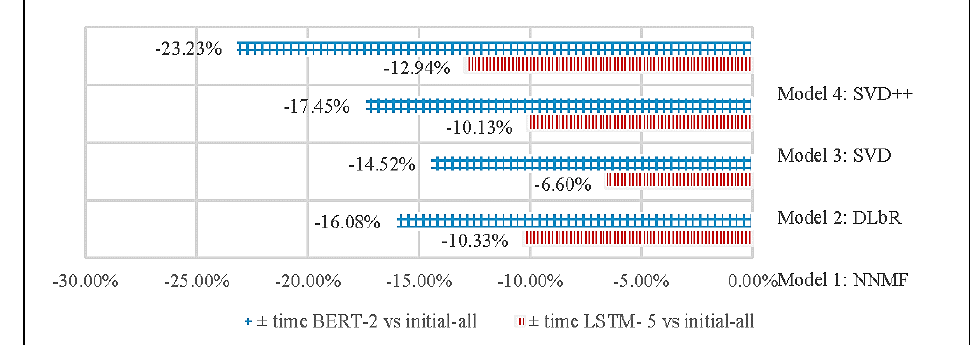
Figure 12. Comparison of the variations produced when using LSTM-5 or BERT-2 against the dataset 𝐷𝐴𝑇𝐴 𝑖𝑛𝑖𝑡.−𝑎𝑙𝑙 , of the four models in total running time.